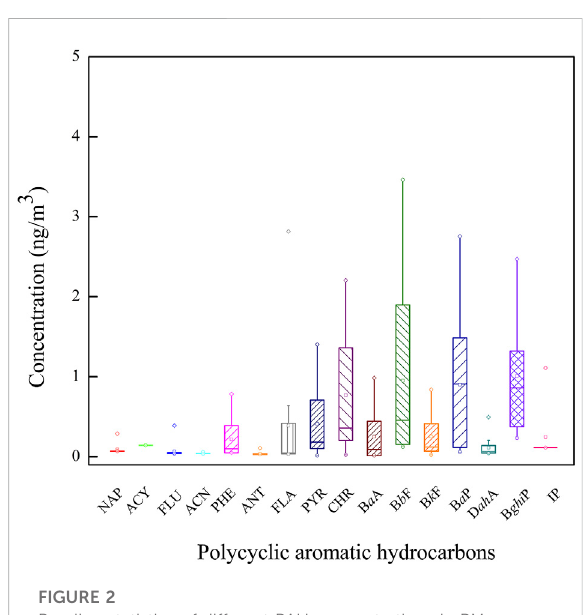
Figure 2. Among the 16 PAHs determined, the content range of